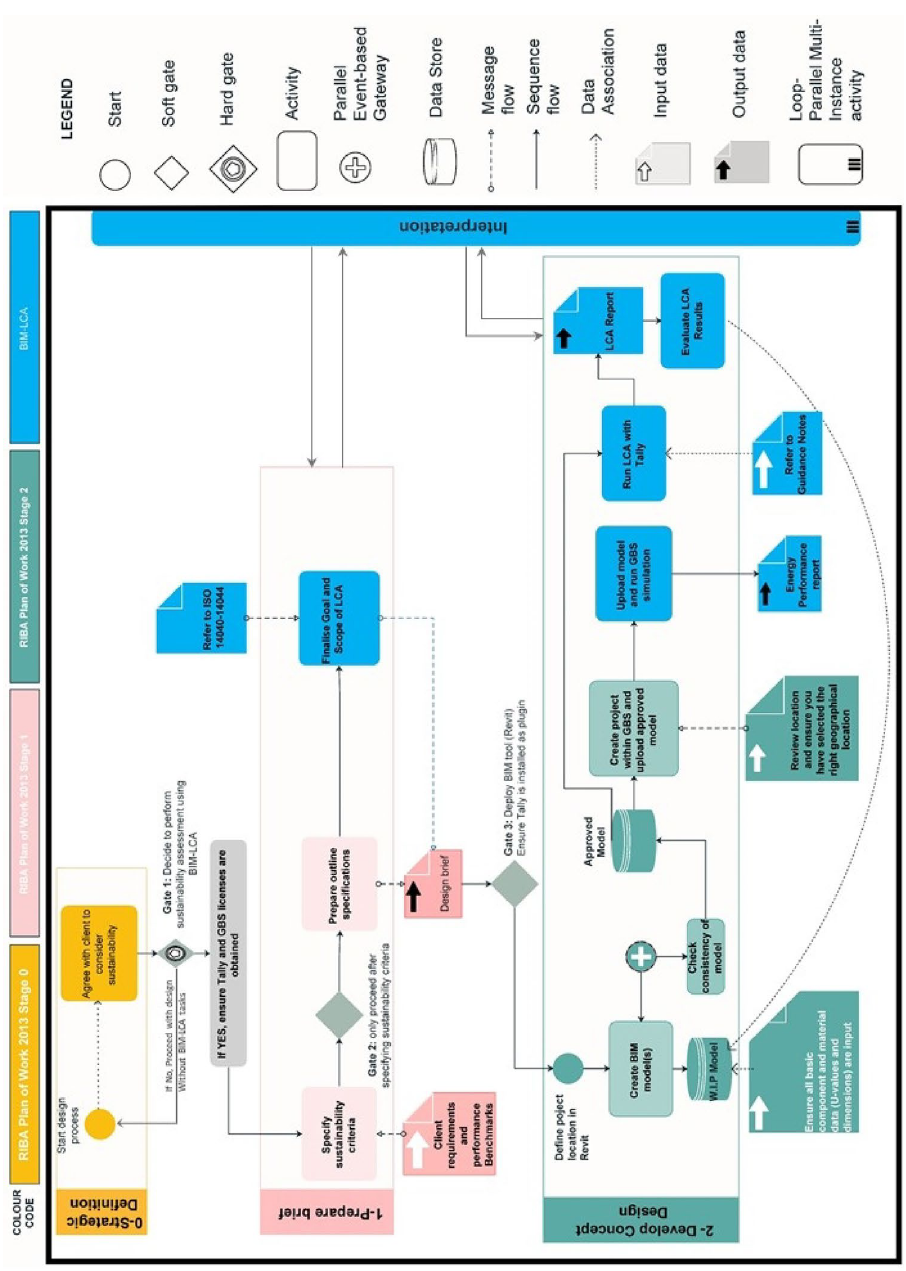
Fig. 8 Workflow process for BIM-LCA enabled sustainabil- ity assessment during early design